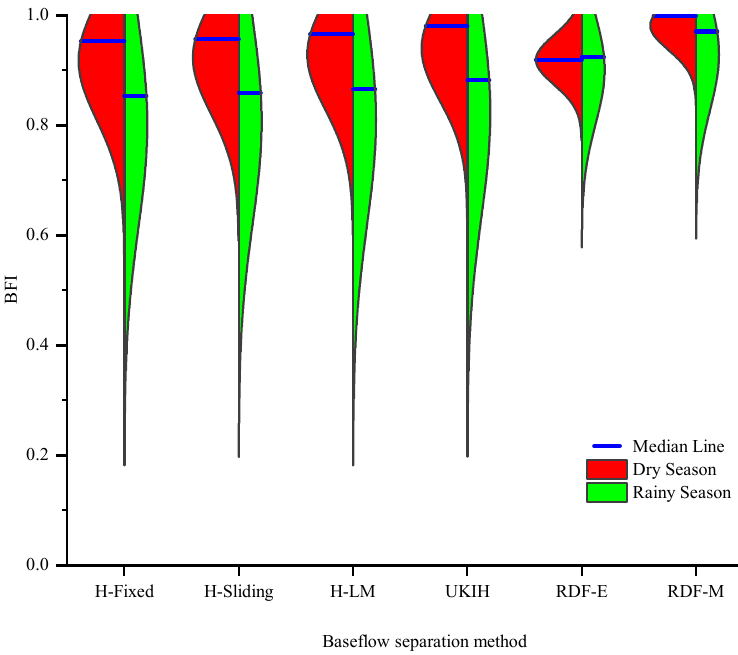
Figure 11. Comparison of baseflow variation process obtained by di ff erent baseflow separation Figure 11. The distribution of daily BFI obtained by different automatic baseflow separation methods in the dry season and rainy season. methods ( a ) precipitation, ( b ) UKIH, ( c ) H-Fixed, ( d ) H-Sliding, ( e ) H-LM, ( f ) RDF-E, ( g ) RDF-M, ( h ) tracer-based